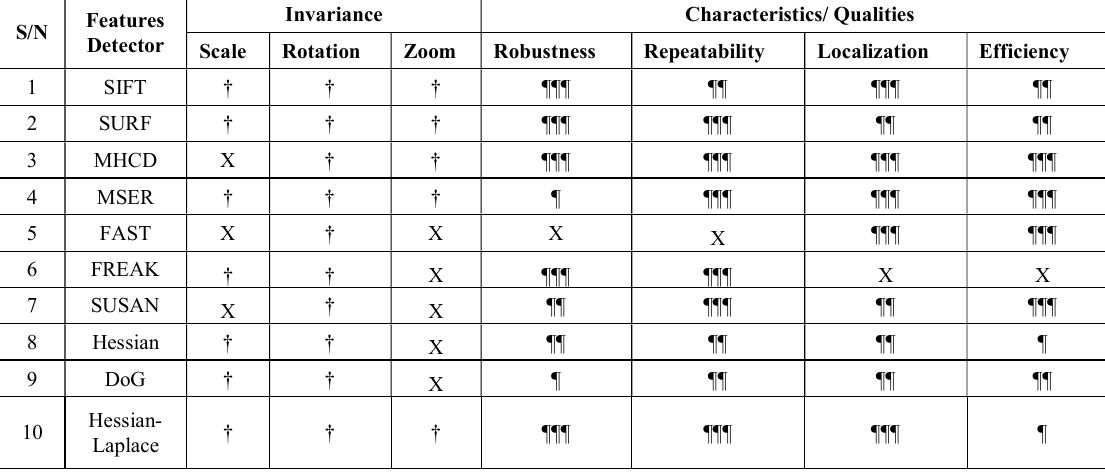
Table 2: Weighted analysis of the qualities of selected feature descriptors Features S/N